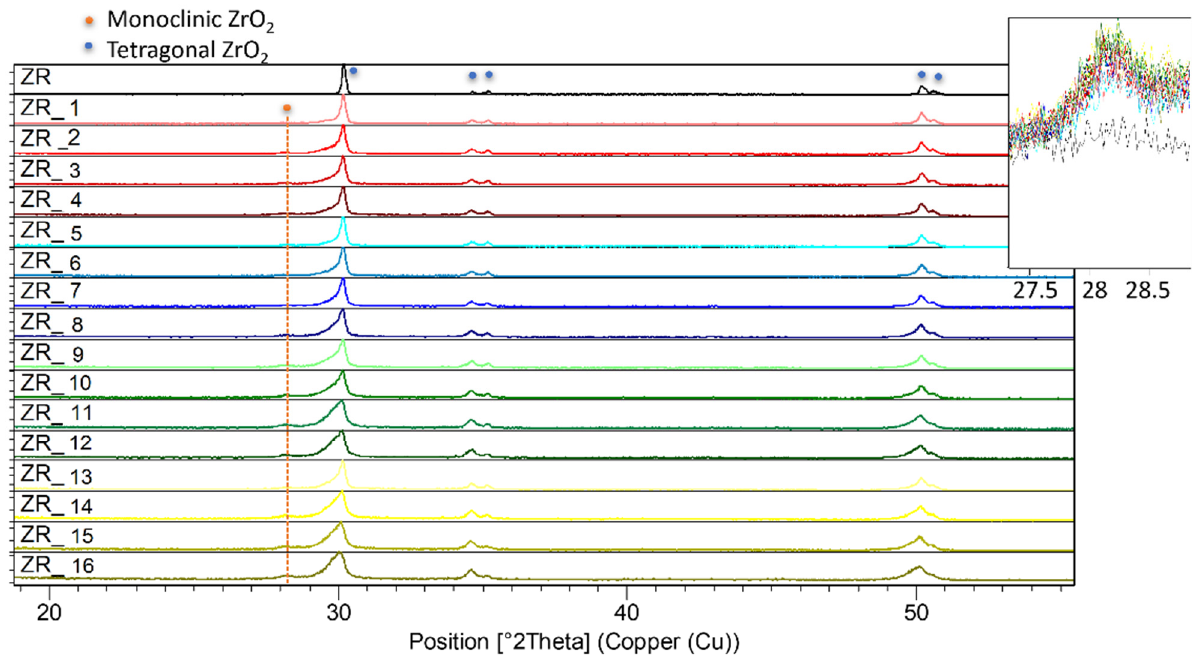
Figure 3. PXRD patterns of the ZR control sample and all the samples sandblasted by the Al 2 O 3 powders under different pressures. Inset shows the strongest line ( 111(cid:3364) ) of monoclinic ZrO 2 phase present in all the sandblasted samples.